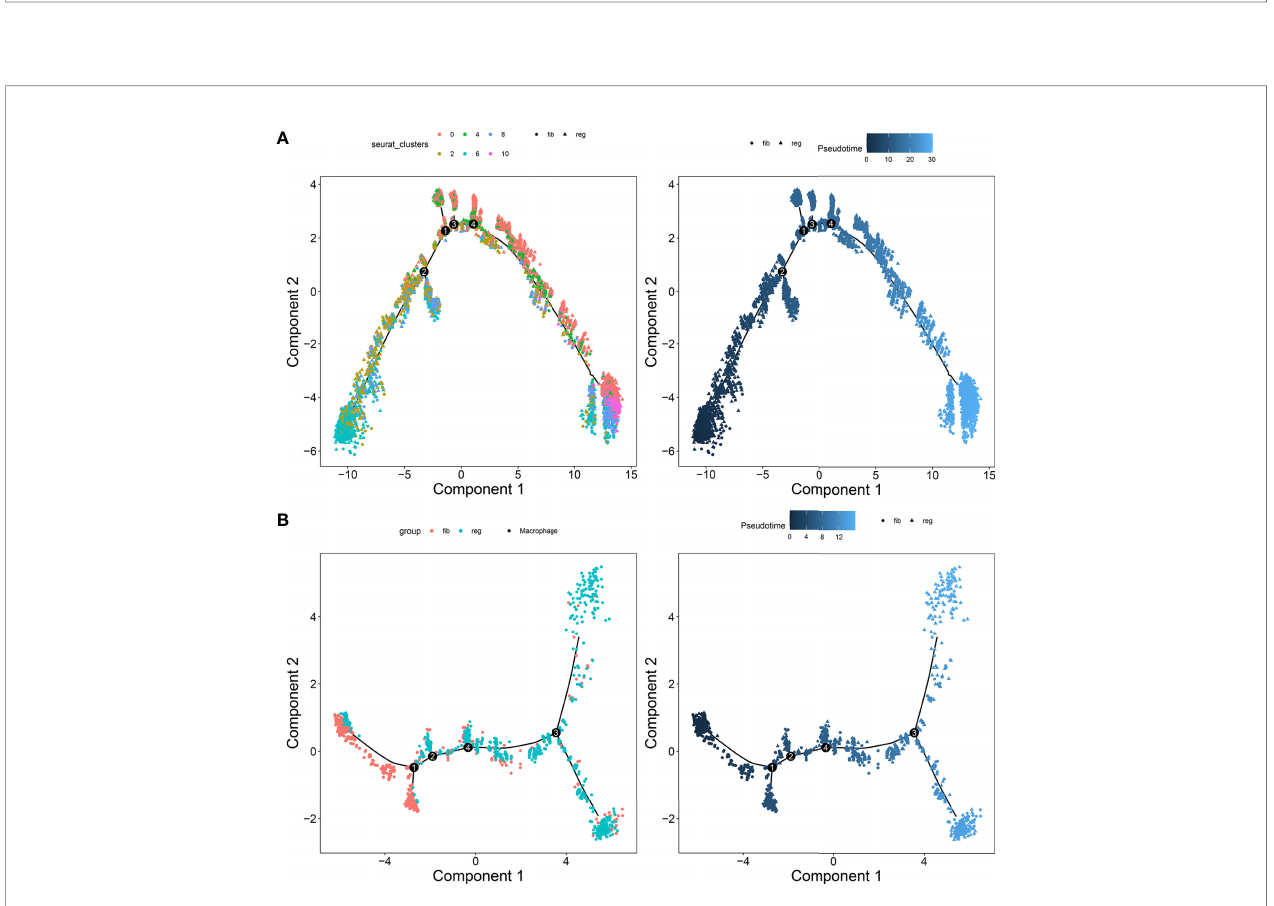
FIGURE 7 | Pseudotime ordering of myo fi broblasts and macrophages. (A) Myo fi broblasts and (B) macrophages. Each dot represented one cell and each branch represented one cell state. The left plot was labeled with cell states and the right plot was labeled with developmental